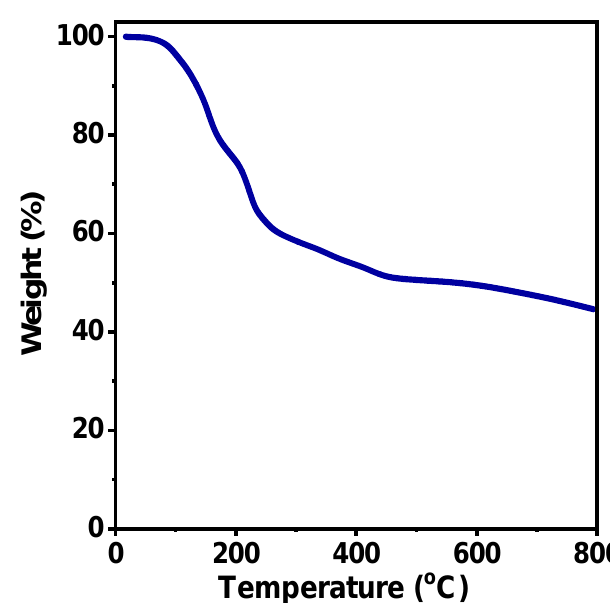
Figure 3. Thermogravimetric analysis (TGA) of the FeS 2 –ethylenediamine precursor.